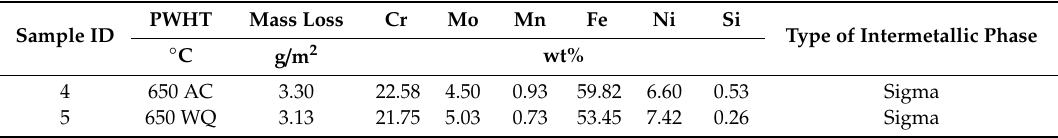
Table 4. Semi-Quantitative Analysis obtained from EDX